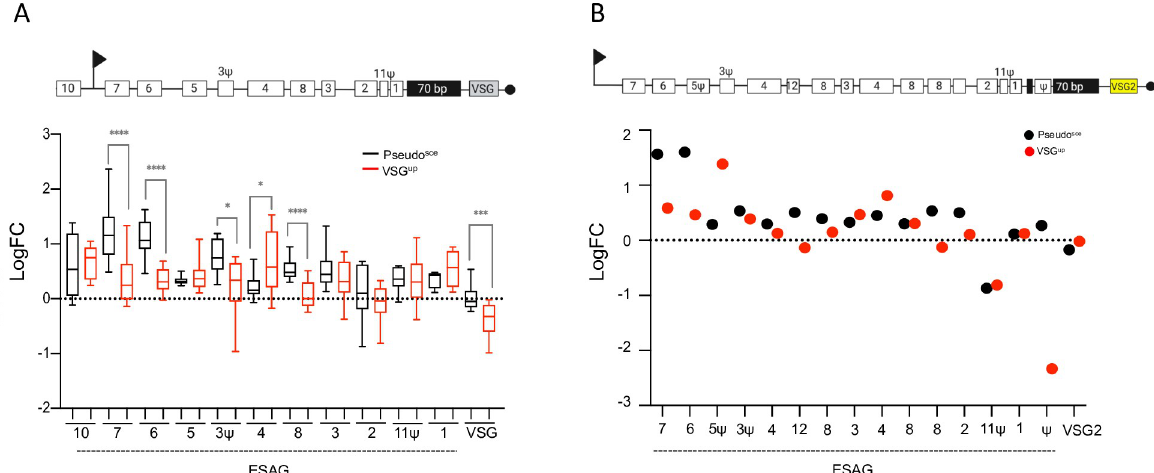
Fig 5. A DSB in the active pseudo gene leads to an increase in expression in ESAG6 and 7 . (A) Upper panel: Schematic depicting a generic BES. Lower panel: The box-plot depicts the sum of BES linked ESAG and VSG genes expression; whiskers extend from the minimal to the maximal value. Centre line indicates the mean. (B) Upper panel: Schematic depicting the actively expressed BES1 with VSG2 at the telomeric end. Lower panel: The plot depicts the sum of BES1 linked ESAG genes and VSG2 expression. (All genes are included in S1 Table). Values are averages of three independent replicates relative to wild-type